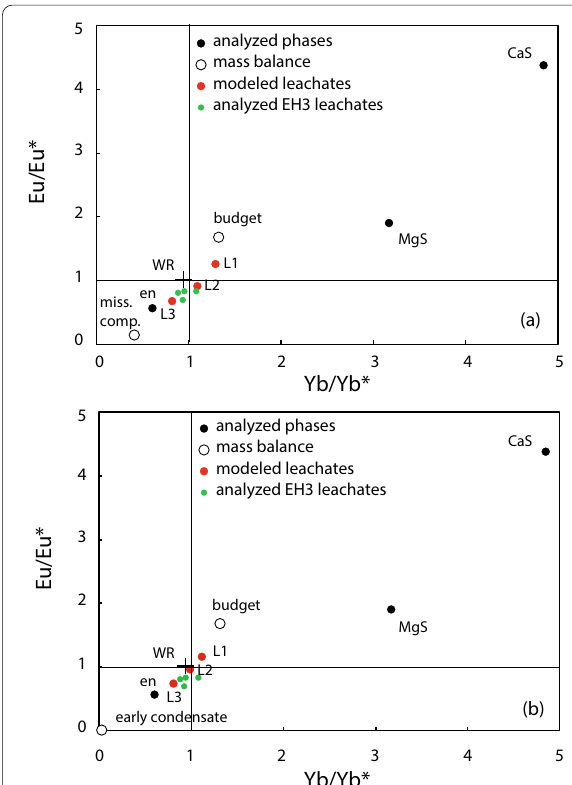
Fig. 8 Eu/Eu* versus Yb/Yb* of modeled leachates obtained by mixing the matrix component and a fraction of the sulfides present in EH3 (CaS and MgS). WR whole rock (averaged from Gannoun et al. = 2011; Barrat et al. 2014); budget reconstruction of the whole rock = composition using mineral modes and REE abundances in CasS, MgS, and enstatite; en enstatite; CaS oldhamite; MgS niningerite = = = (from Gannoun et al. 2011). Leachates L1, L2, L3 are modeled by varying the relative proportions of the matrix component and sulfides, so as to illustrate the possible combinations for the sign of the Eu and Yb anomalies observed in leachates (Boyet and Gannoun 2013; Barrat et al. 2014). a The matrix component consists of the missing component identified by mass balance. Leachate L1 is obtained by mixing this component with 14% and 75% of the CaS and the MgS present in the rock, respectively; L2 by using 8% of the CaS and 100% of the MgS; L3 by using 5% of the CaS and 30% of the MgS. b The matrix composition is modeled as an early condensate (see Fig. 6). Leachates are simulated by mixing this condensate with CaS and MgS in the following proportions: L1 92.8% =